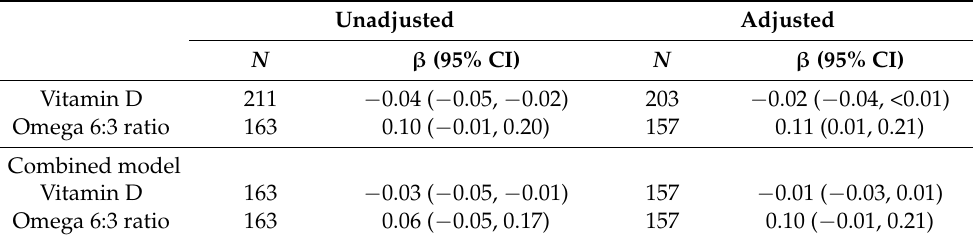
Table 3. Associations between selected serum micronutrients and C-reactive protein in individuals with and without chronic